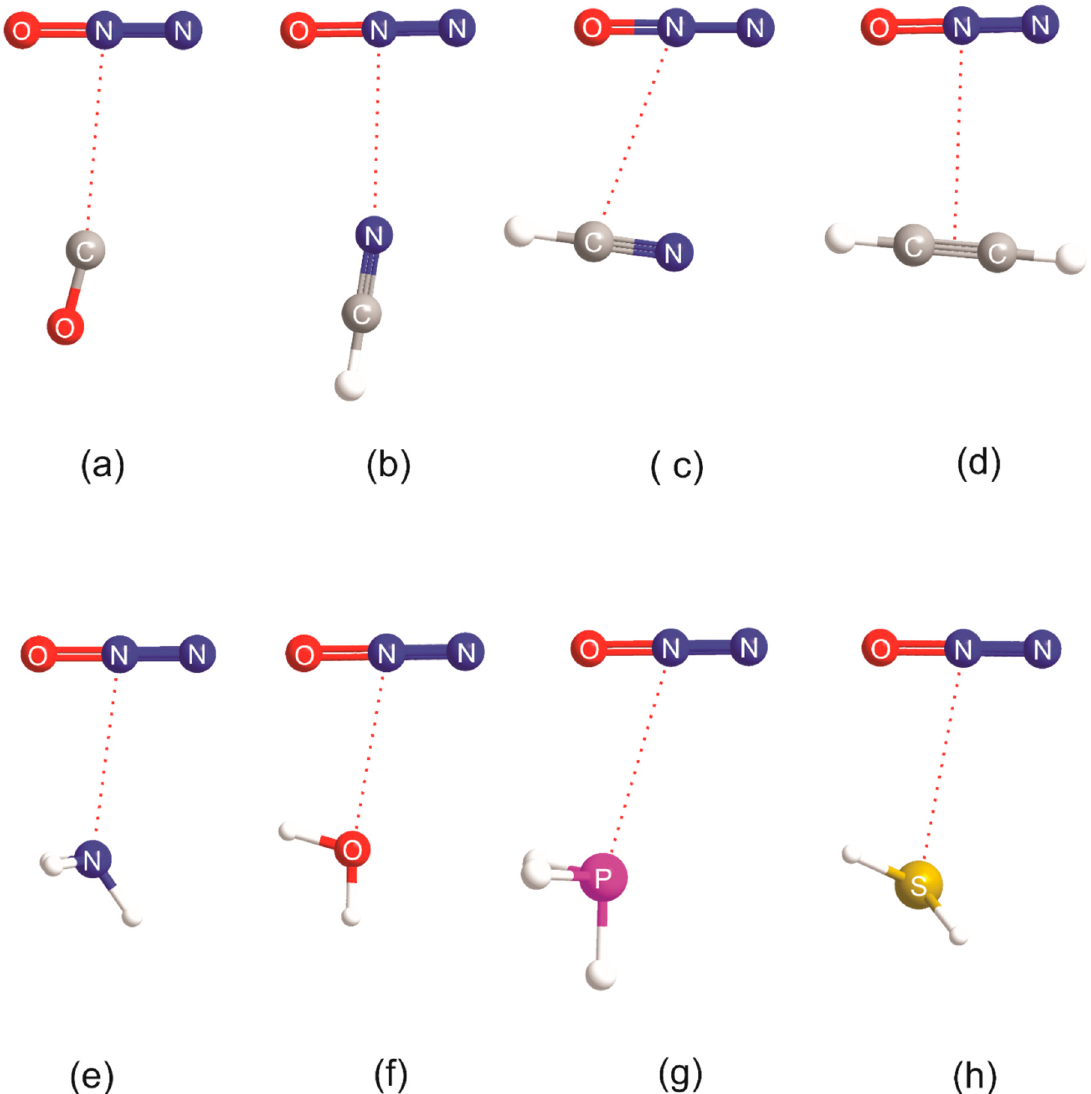
Figure 5. Molecular models drawn to scale of the geometries of B ⋯ N 2 O complexes calculated at the CCSD(T)/aug-cc-pVTZ level of theory, where B = CO, HCN, HCCH, NH 3 , H 2 O, PH 3 , and H 2 S ( a – h , respectively; note that there are two models shown for HCN complexes). When B = HCN there are three low-energy conformers: the slipped parallel form at the global minimum, the T-shaped isomer higher in energy by only 0.03 kJ·mol − 1 , and a linear, hydrogen-bonded conformer N 2 O ⋯ HCN (not shown) higher in energy by 1.3 kJ·mol − 1 (see text for discussion).